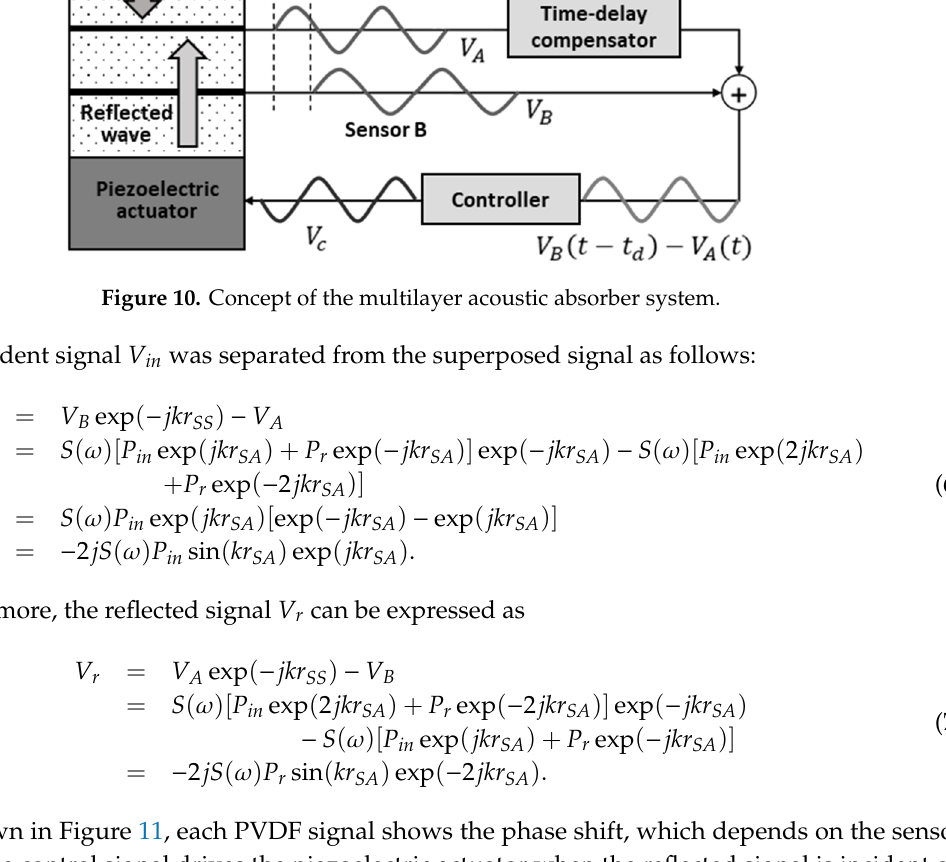
Figure 10. Concept of the multilayer acoustic absorber system.